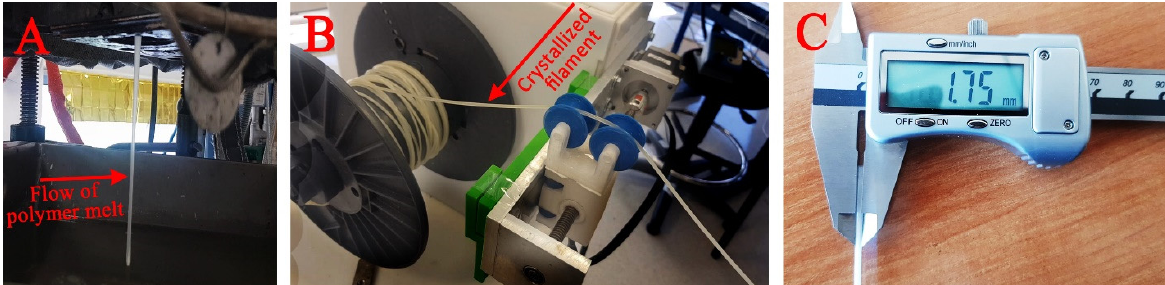
Figure 9. The flow of the polymer melt (PBS-DLS-PEG 6000 70-20-10) directly into a water bath ( A ); the rotating collector at the end of the water bath with adjustable turning speed ( B ); and the diameter of the obtained filament after adjusting the speed of the collector ( C ).